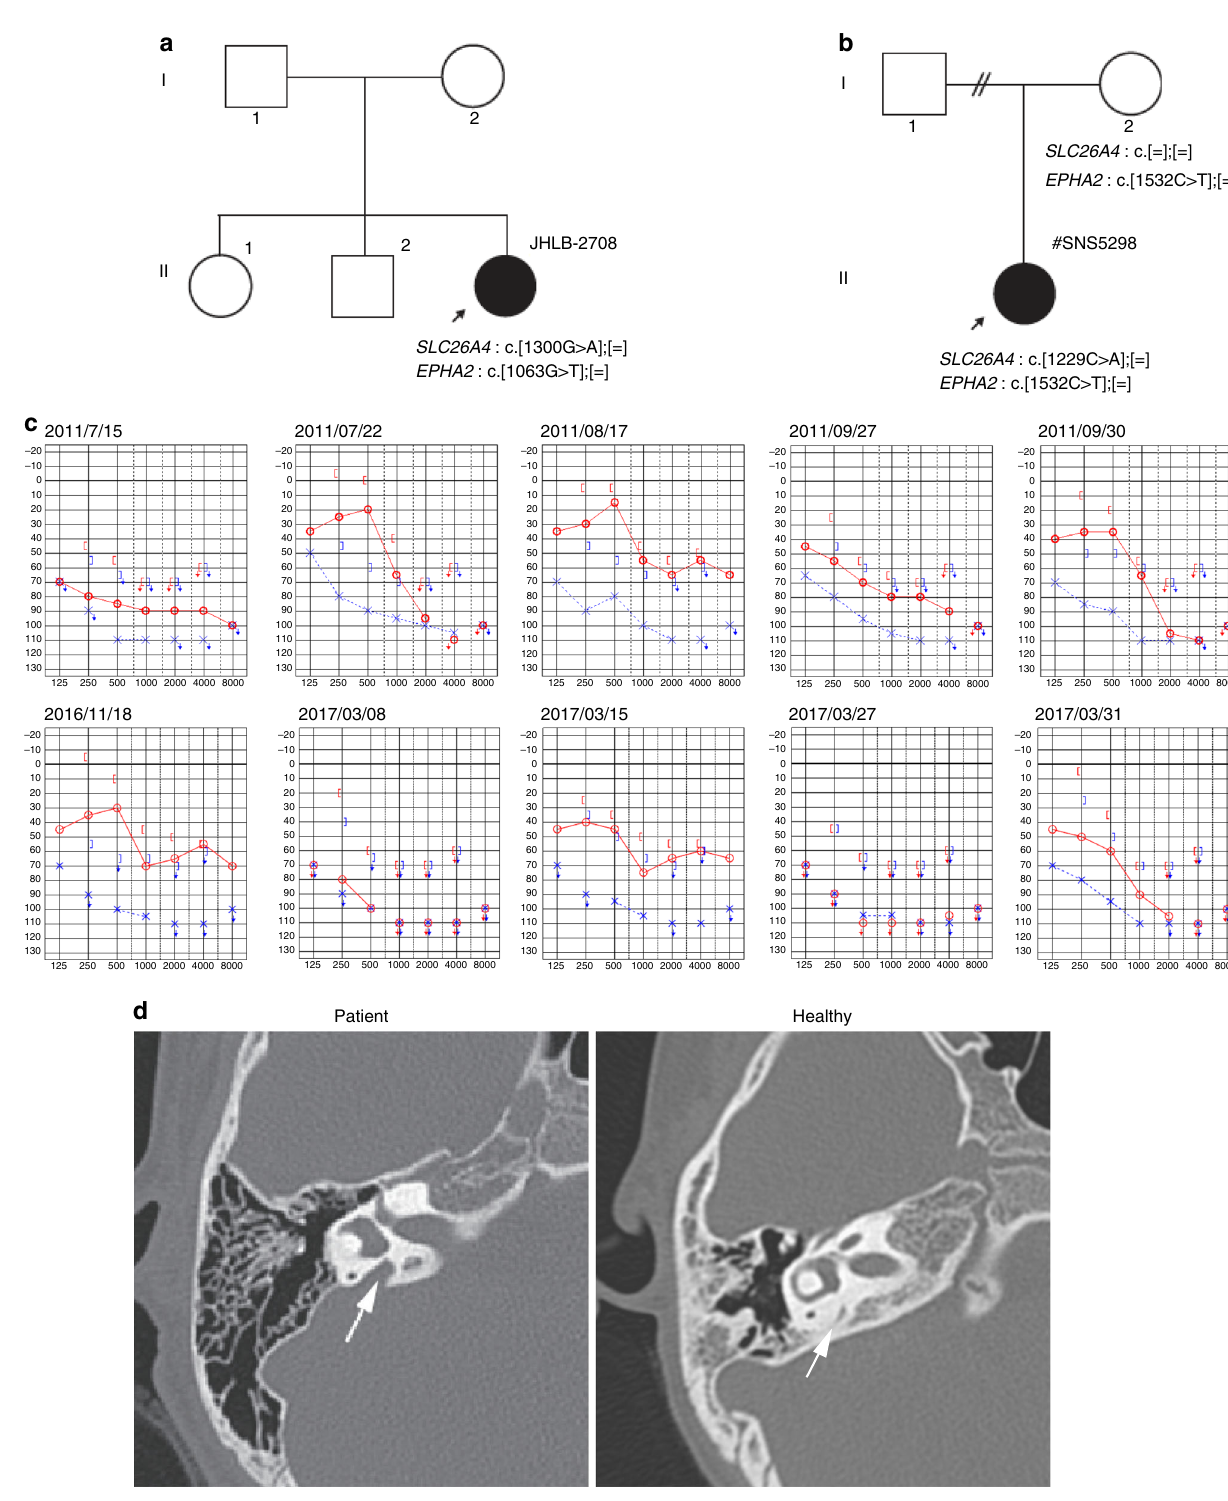
Fig. 6 Identi fi cation and characterization of EphA2 mutation from hearing loss patients with EVA. a , b Pedigree chart of the patients carrying mono- allelic EPHA2 and SLC26A4 mutations. c Audiograms of the patient with mono-allelic EPHA2 p.T511M and SLC26A4 p.T410M mutations. d Temporal bone computed tomography (CT) scan of the patient with mono-allelic EPHA2 p.T511M and SLC26A4 p.T410M mutations. The arrow indicates the vestibular aqueduct in the patient and the healthy